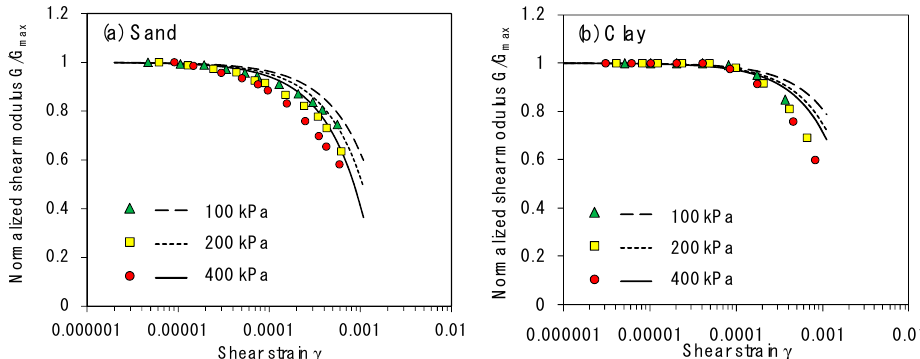
Figure 4. Damping ratios of sand and clay under three different confinement stress levels (sand data from 16~18 and clay data from 1~3 in Table 1): ( a ) Sand; ( b ) clay. The symbols are experimental data and the lines are defined by Equations (7) and (10).